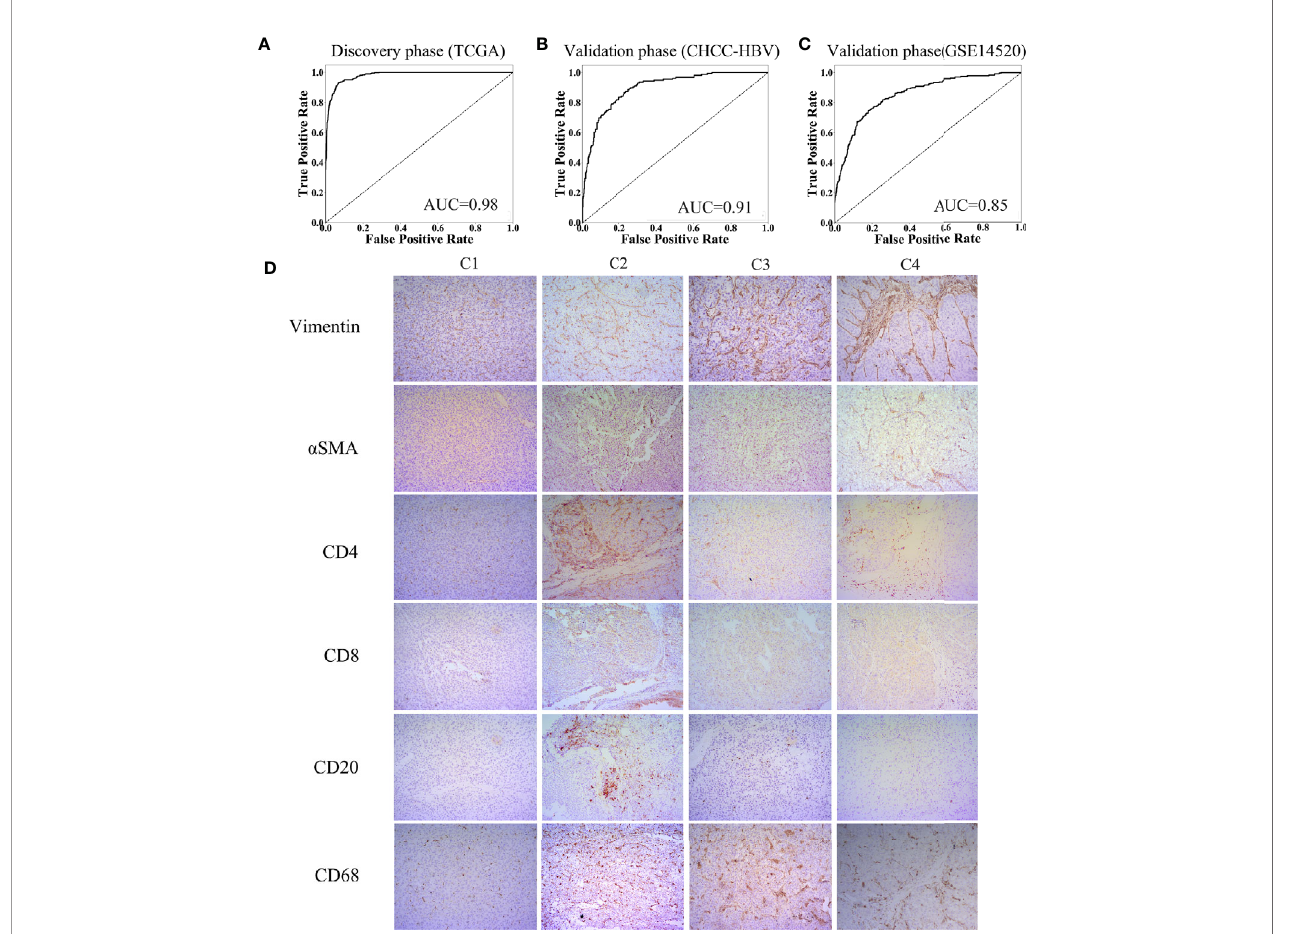
FIGURE 5 | Construction of support vector machine model and performance validation. ROC curves for classi fi ers designed to predict the immune subclass for TCGA (A) , CHCC-HBV (B) , and GSE14520 (C) . (D) Representative immunohistochemical pictures of HCC samples belonging to each subclass (100X) (Zhejiang